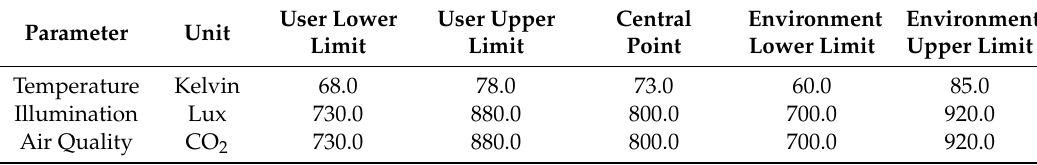
Table 3. Considered parameters and their value